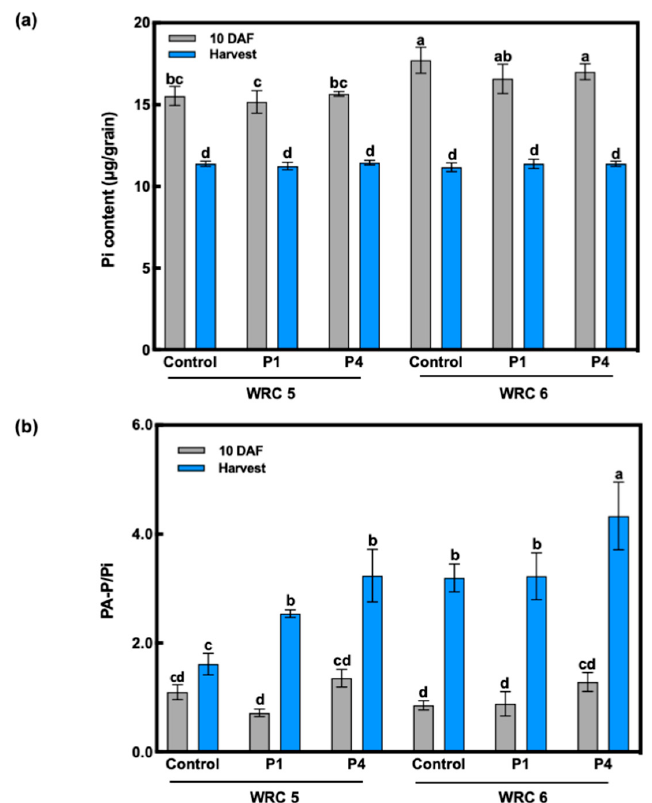
Figure 3. E ff ect of the amount of P fertilizer on Pi and PA-P / Pi in WRC 5 and WRC 6. (a ) Pi content per gram dry weight ( µ g / grain) and ( b ) PA-P / Pi ratio at 10 DAF and harvest. Gray and blue represent the value at 10 DAF and harvest, respectively. Each value represents the mean ± SD of four replicates. Di ff erent letters indicate statistical di ff erences (Tukey’s HSD test, p < 0.05).